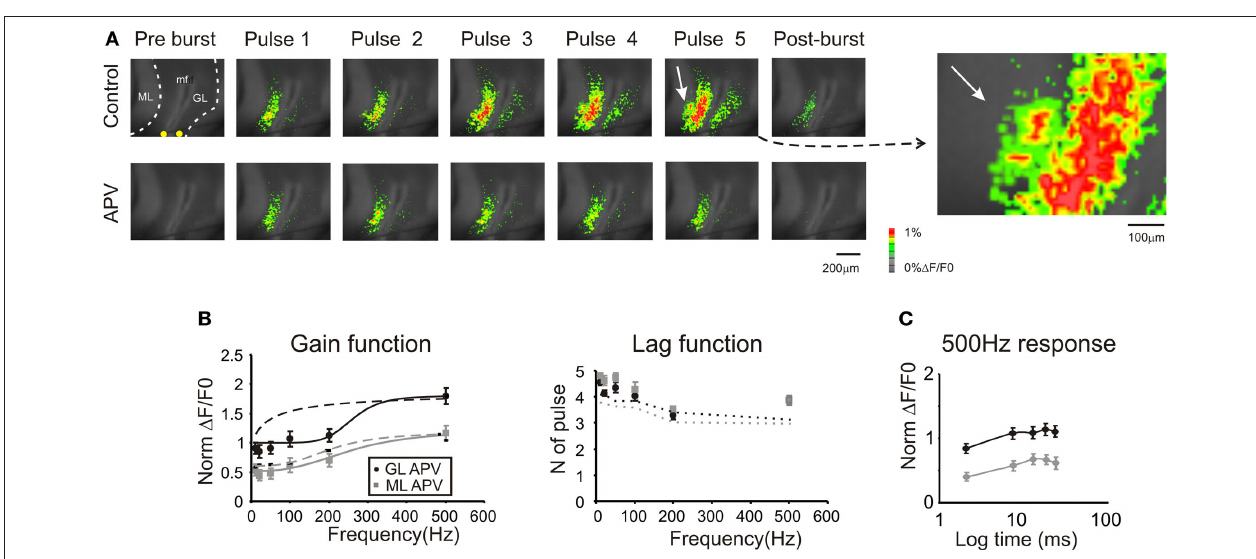
FiGure  | regulation of frequency-dependence by NMDA receptors. (A) Optical maps were obtained at the peak of responses in five-pulse 200 Hz bursts delivered to the white matter. Application of 50-μM APV markedly reduced amplitude and extension of responses in the granular and molecular layer, and the response remained stationary during the bursts. After the end of the burst (50 ms) APV reduced the remaining part of the response which was probably generated by the summation of NMDA dependent currents. The enlarged map evidences the molecular layer region (white arrow) which was activated in control condition. (B) Maximum response amplitudes were measured for each of the